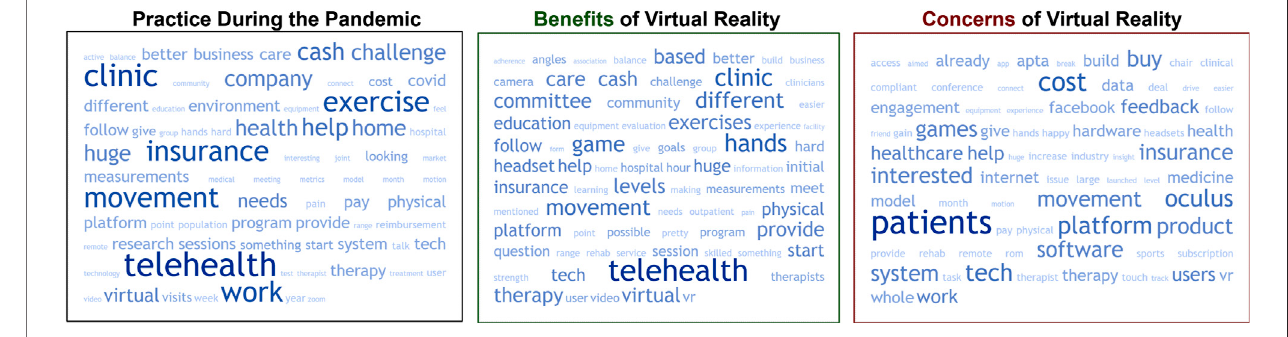
FIGURE 4 | Wordclouds generated from interviews on practice during the pandemic, perceived bene fi ts and concerns of VR.